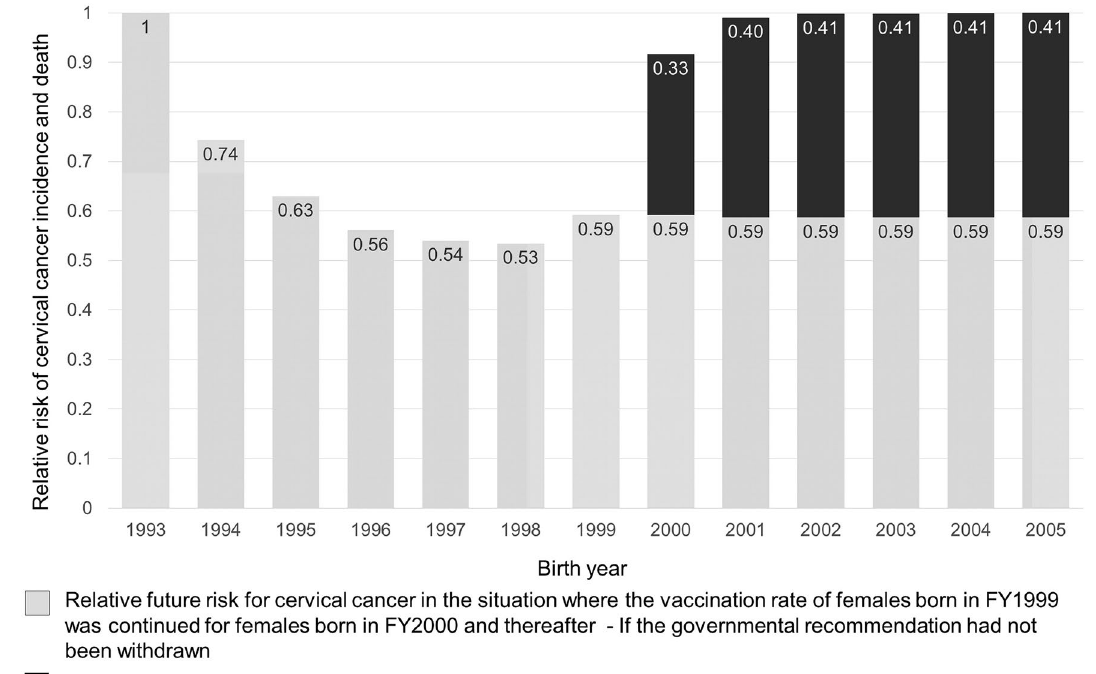
Figure 1. Estimated number of future cervical cancer mortalities and deaths generated daily. We set the future risk of cervical cancer incidence and death in females born in FY1993 as the baseline of 1 (these females were never vaccinated, because they were over-aged (> 16) for receiving HPV vaccination when public subsidies started in FY2010). FY: fiscal